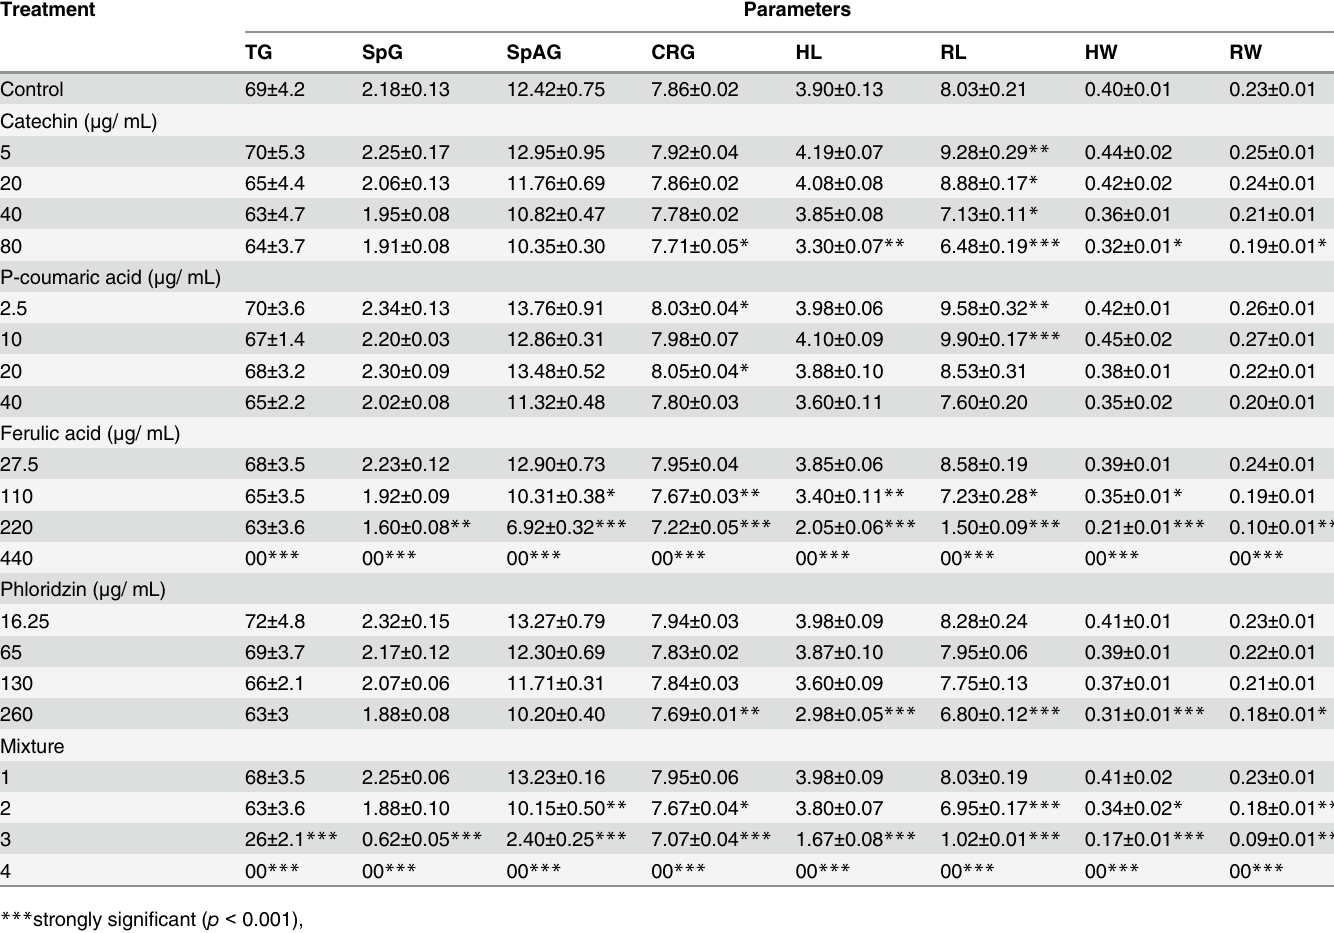
Table 1. Impact of standard phenolic compounds (dose response) on germination indices and biometric parameters of I . axillaris . Data presented as average ± SE. TG = Total germination, SpG = Speed of germination, SpAG = Speed of accumulated germination, CRG = Coefficient of rate of germination, HL = hypocotyl length, RL = radicle length, HW = hypocotyl weight, RW = radicle weight. The asterisks indicate the significant variation compared with